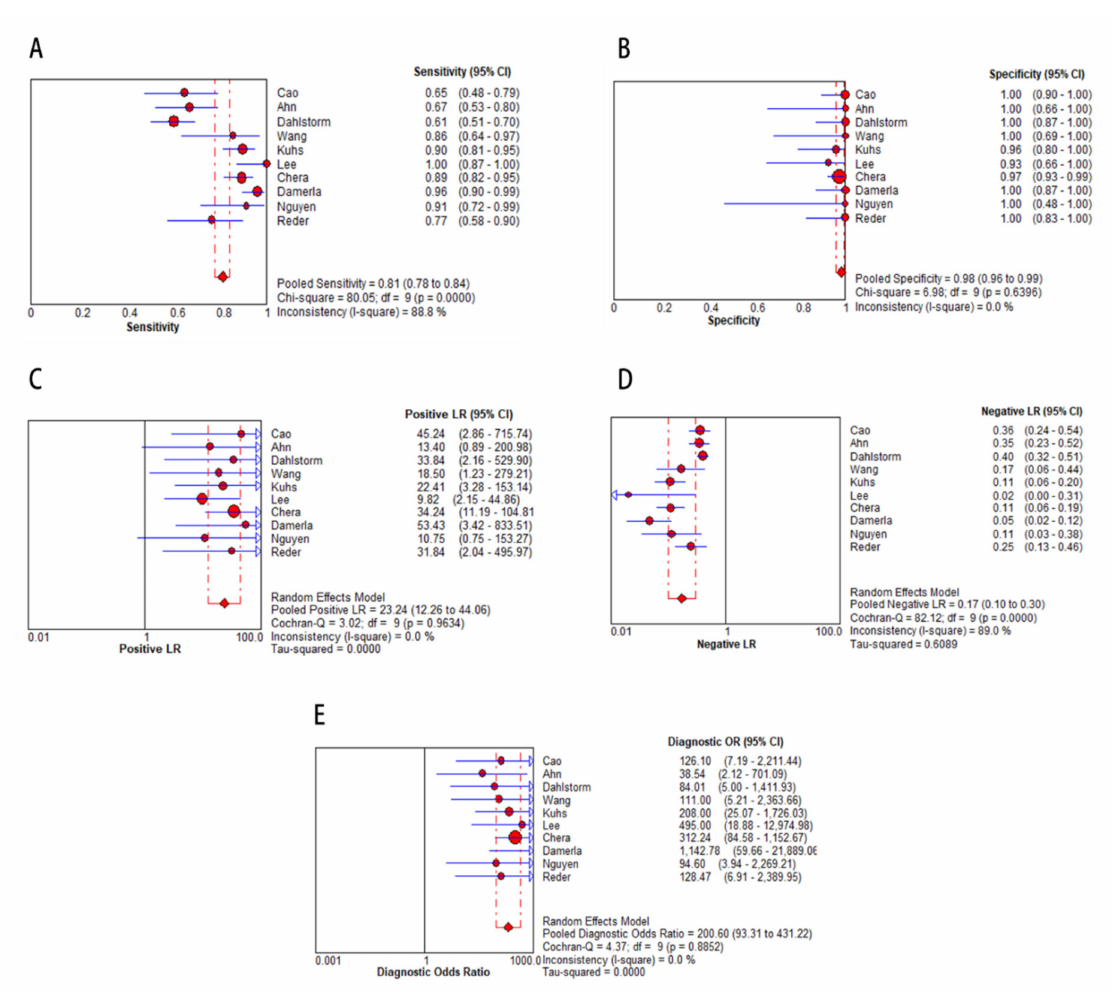
Figure 3. Diagnostic accuracy of cfHPV-DNA displayed by forest plots estimating ( A ) sensitivity, ( B ) specificity, ( C ) positive likelihood ratio (PLR), ( D ) negative likelihood ratio (NLR), and ( E ) diagnostic odds ratio (DOR) at first diagnosis of HPV-related OPSCC (confidence interval (CI) in brackets). The size of red dots represents the sample size included in the